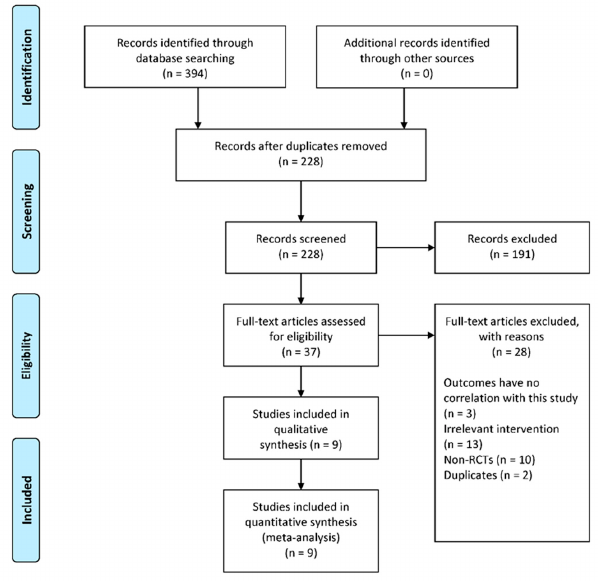
Figure 1. PRISMA flow diagram of study selection.